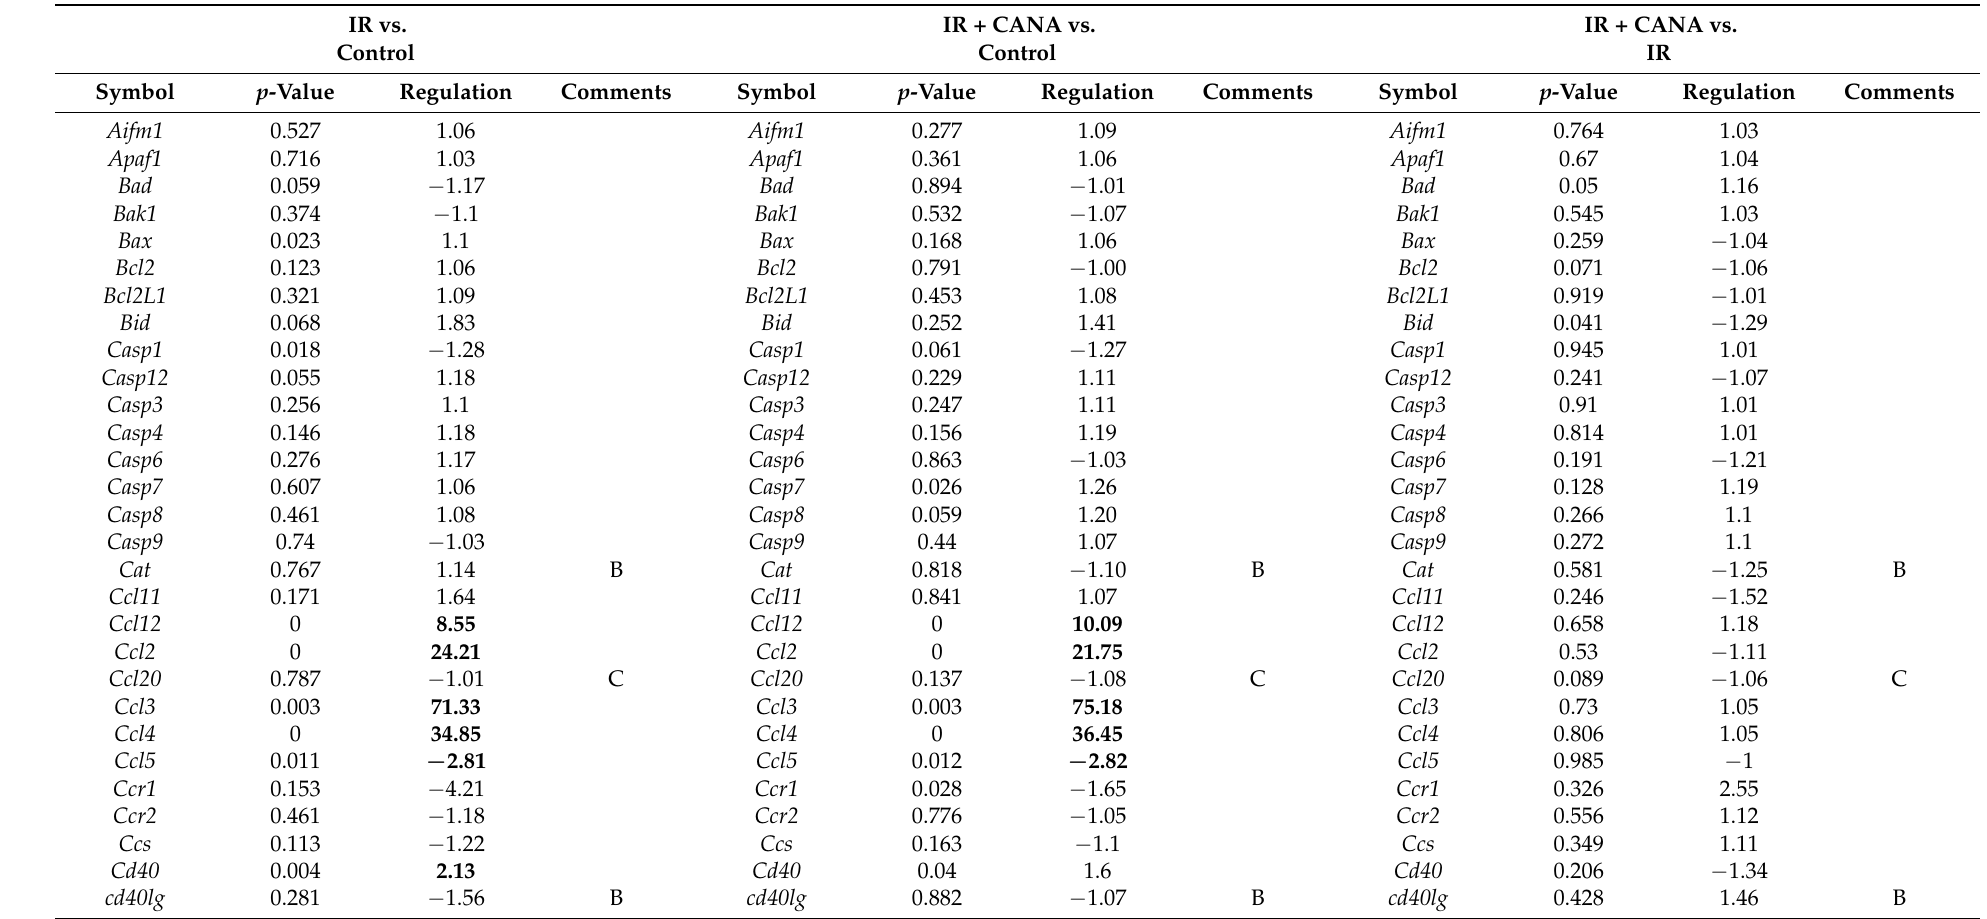
Table 2. Gene expression, including the p -values and fold regulation of all genes tested. For statistically significant genes, fold-regulation values are presented in bold. See Table 1 for gene abbreviations. “A” means that this gene’s average threshold cycle is relatively high (>30) in either the control or the test sample and is reasonably low in the other sample (<30), “B” means that this gene’s average threshold cycle is relatively high (>30) (meaning that its relative expression level is low in both control and test samples, and the p -value for the fold-change is either unavailable or relatively high ( p > 0.05)), and “C” means that this gene’s average threshold cycle is either not determined or greater than the defined cut-off value in both samples (meaning that its expression was undetected, making this fold-change result erroneous and uninterpretable). IR indicates ischemia/reperfusion and CANA canagliflozin. IR vs. IR + CANA